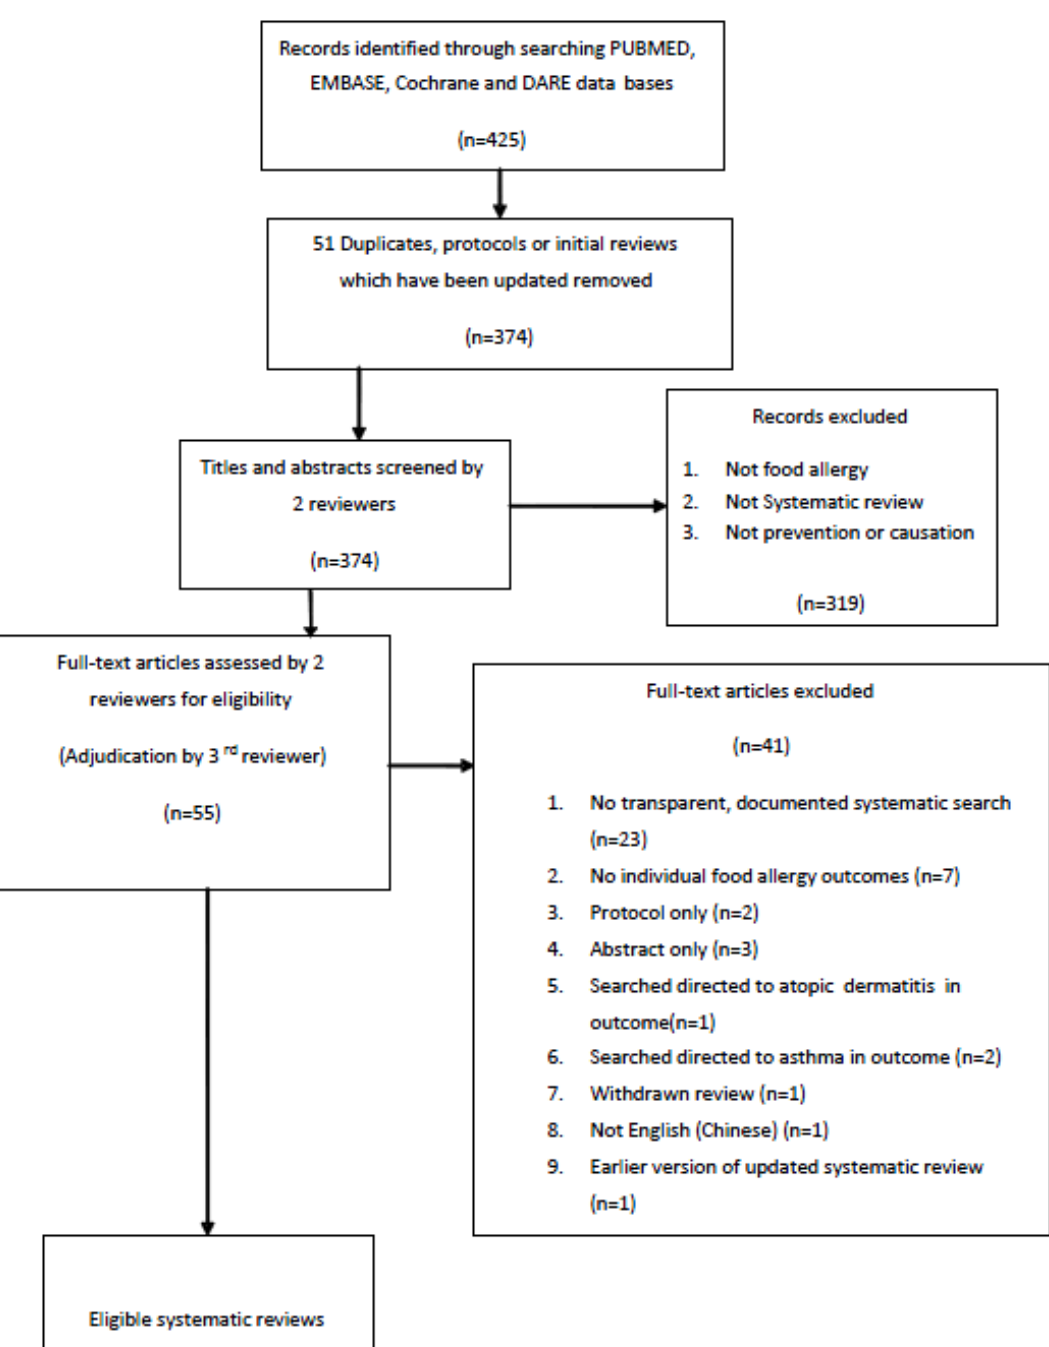
Figure 1. Flow chart of the search